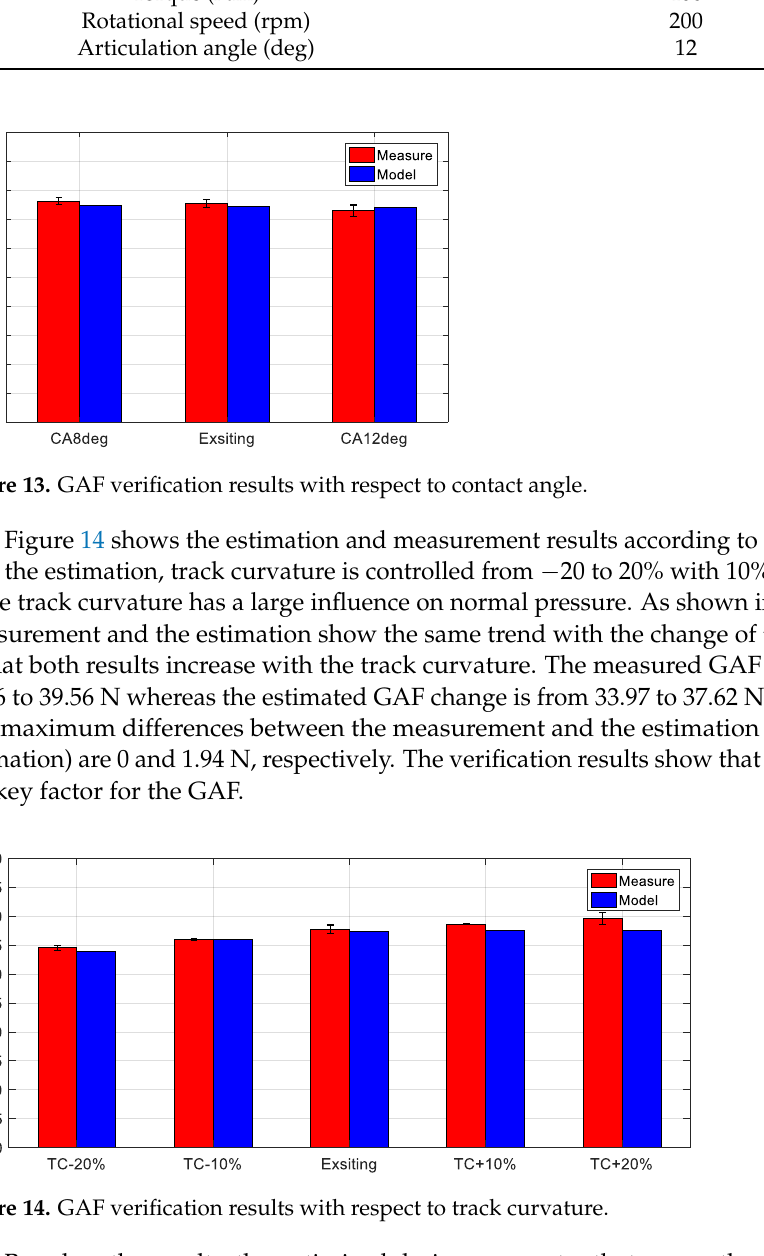
Figure 14. GAF verification results with respect to track curvature.